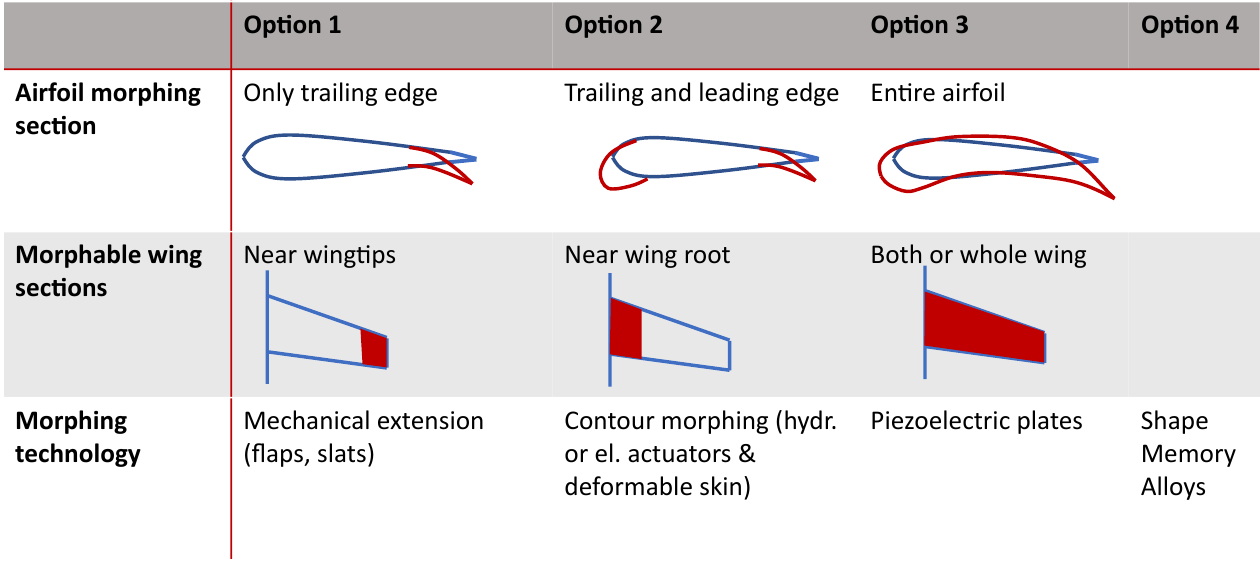
Figure 3. Morphological matrix for the conceptual design of wing morphing